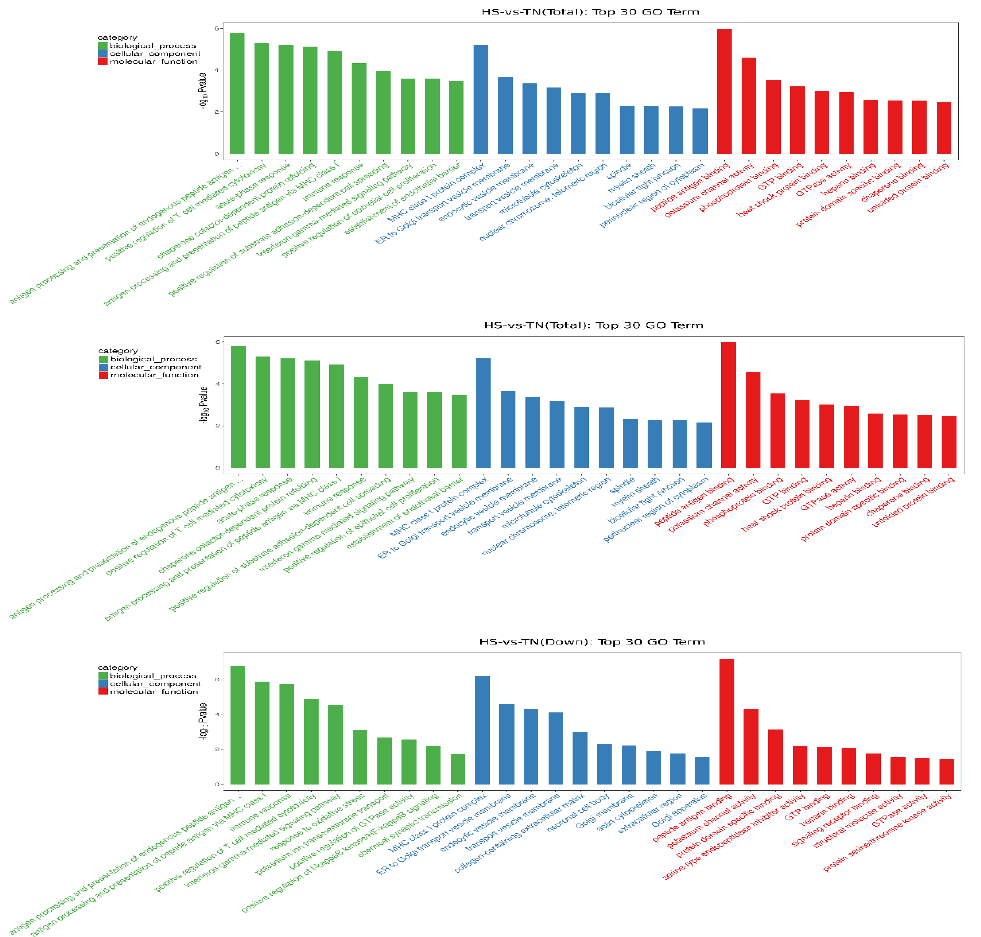
Figure 3. Gene ontology enrichment analysis. The genes from hierarchical clustering were further analyzed with the Database for Annotation Visualization and Integrated Discovery. The categories of the most affected genes were shown as the most upregulated (up), downregulated (down), and overall (total) effected. The top-10 terms in each category, including cellular component, biological process, as well as molecular function, are listed in the column charts.